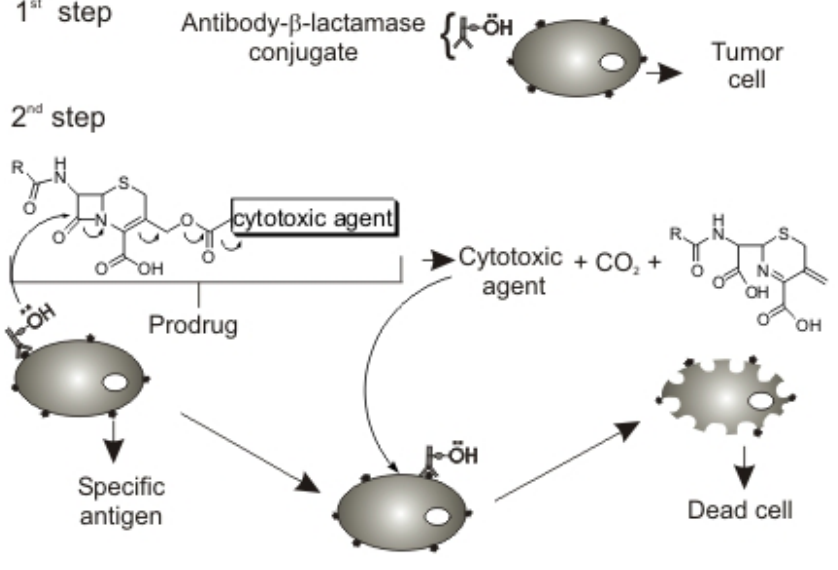
Figure 1. Cephalosporin carrier for the ADEPT